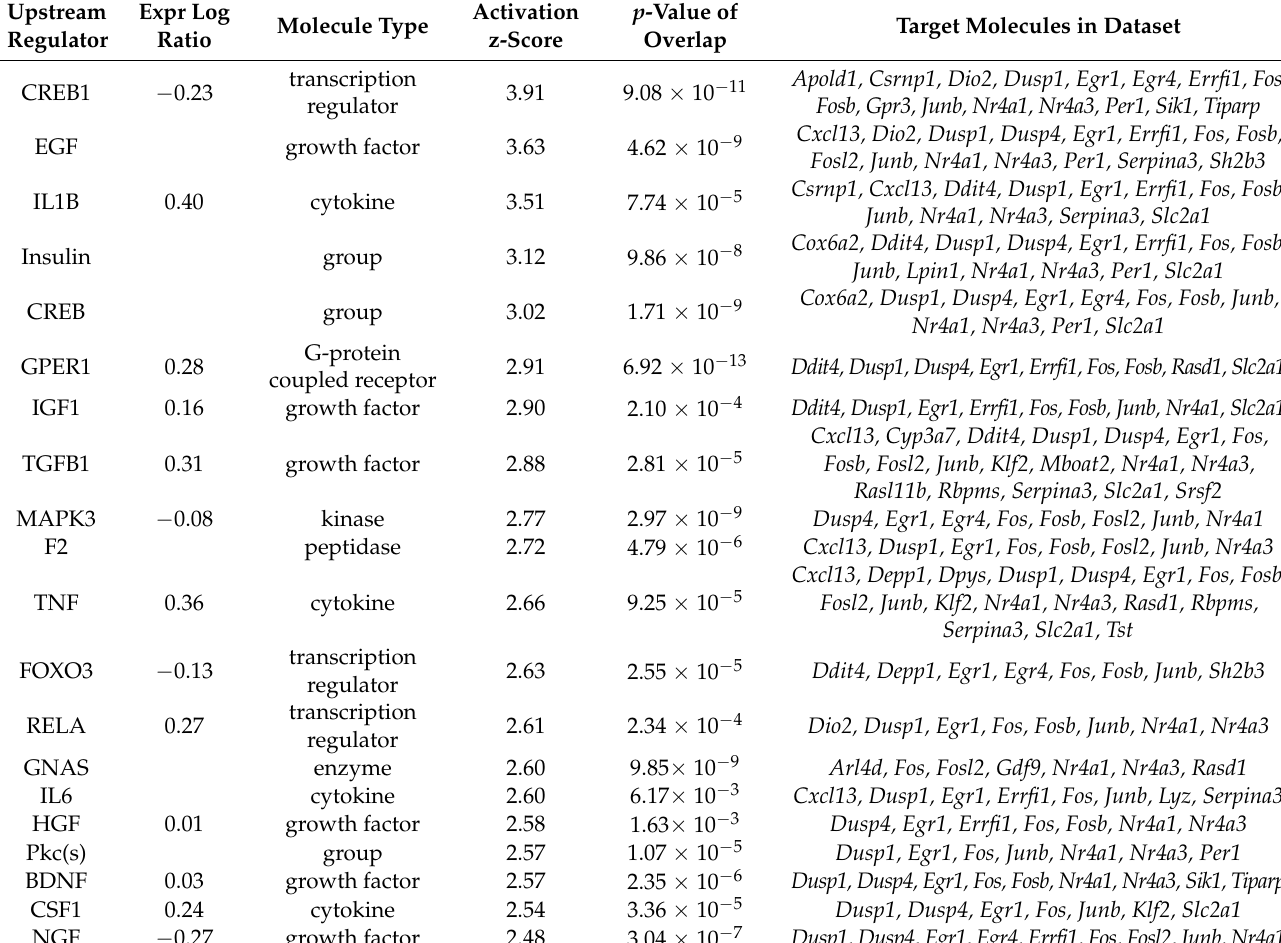
Table 2. Top 20 upstream regulators identified as significantly activated in the “OHT +